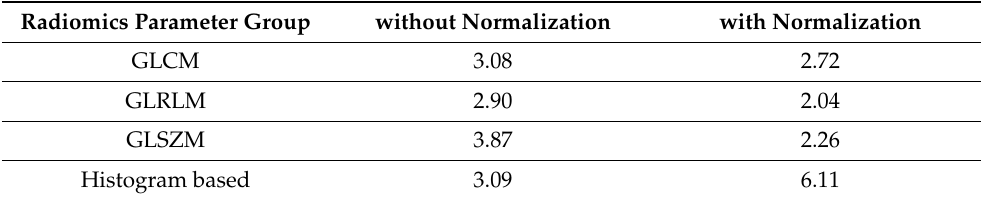
Table 5. CV average computed for each radiomics parameter group for all objects. Radiomics Parameter Group without Normalization with Normalization